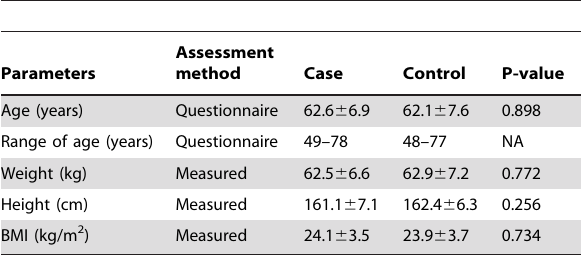
Table 1. Comparisons of anthropometric characteristics of the case and control